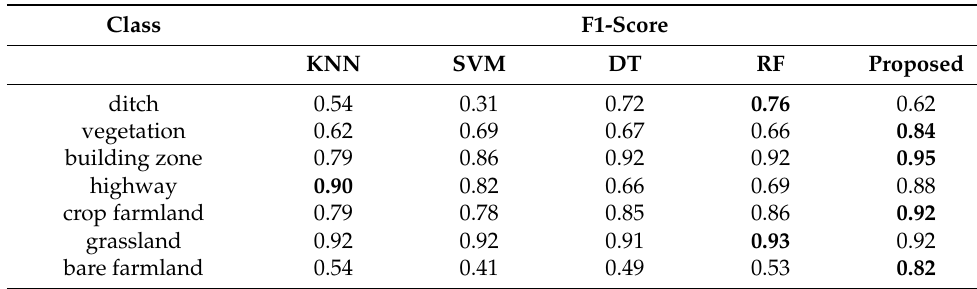
Table 6. Comparison of F1 scores using the KNN, SVM, DT, RF, and proposed methods for experi- mental scene C. Bold represents the highest precision of a same class among these